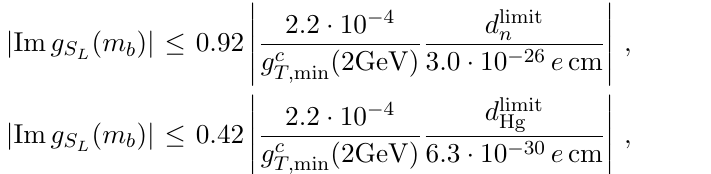
Figure 11 . Contours in the Re g S C.L.) are shown in green and blue, respectively. The current constraints from from the Hg EDM is shown in red, while the dark-red band is a projection for a future neutron EDM measurement assuming an order of magnitude